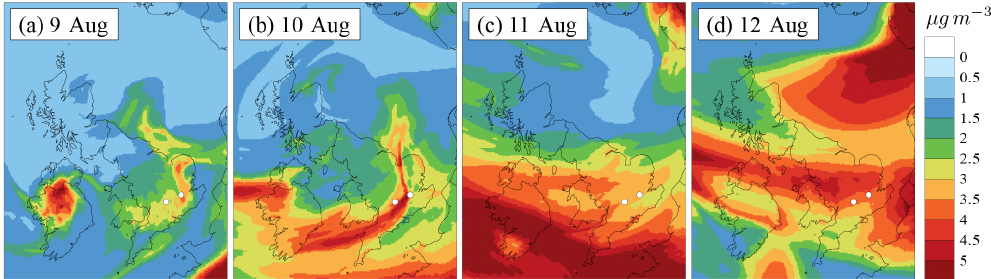
Figure 12. Modelled (addDiesel experiment) daily average concentrations of SOA during the second SOA episode of the summer 2012 IOP. The white circles mark the measurement site locations – left: Harwell; right: London North Kensington.